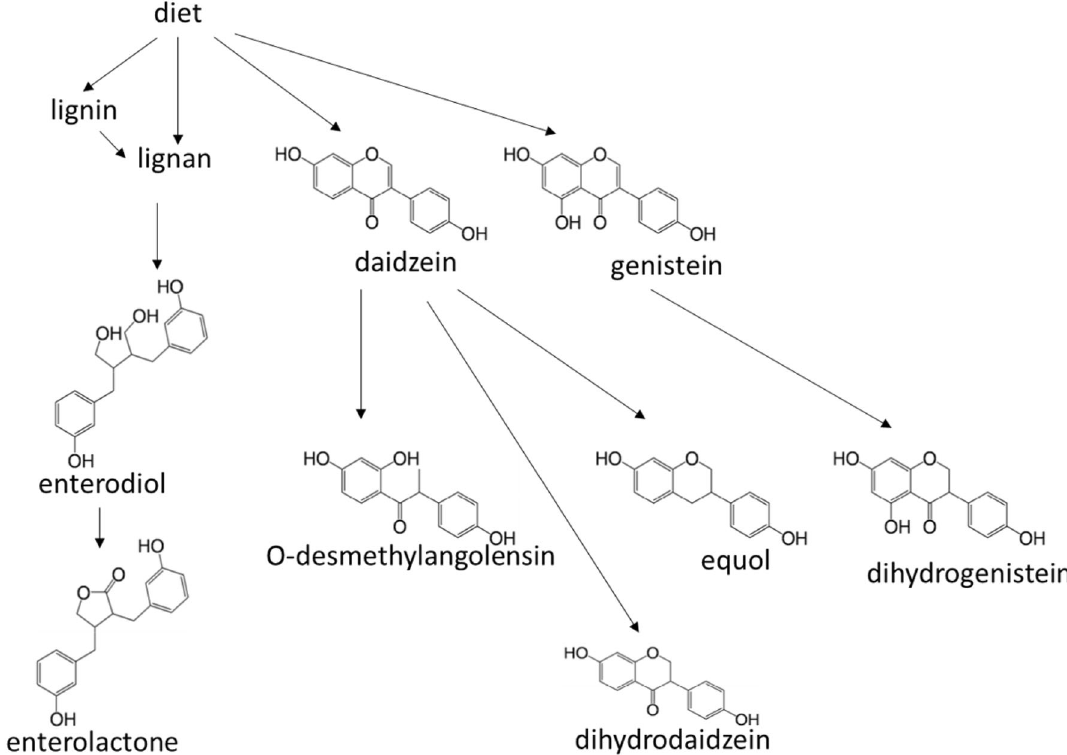
Figure 4. Structural formulas of phytoesterogens and the metabolism